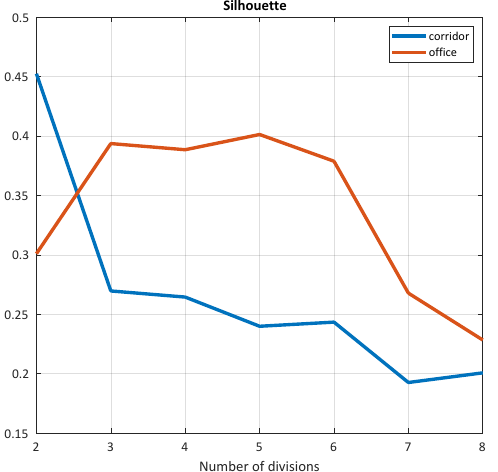
Figure 8. Results of the divisions by means of a spectral clustering method for office and